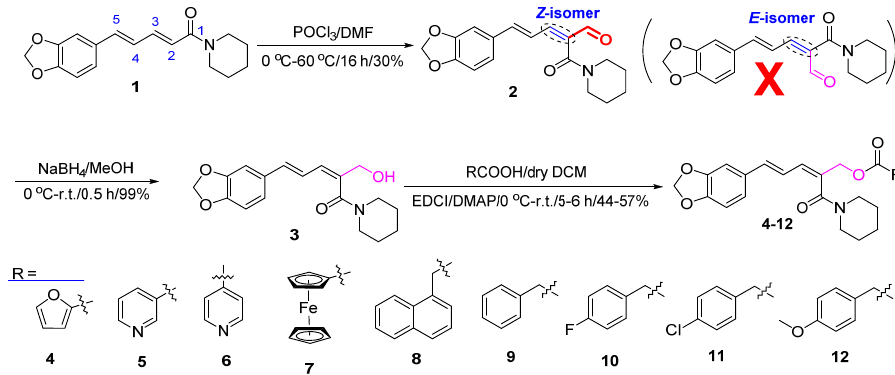
Figure 2. Synthetic route for the preparation of piperine ester derivatives ( 2–12 ).